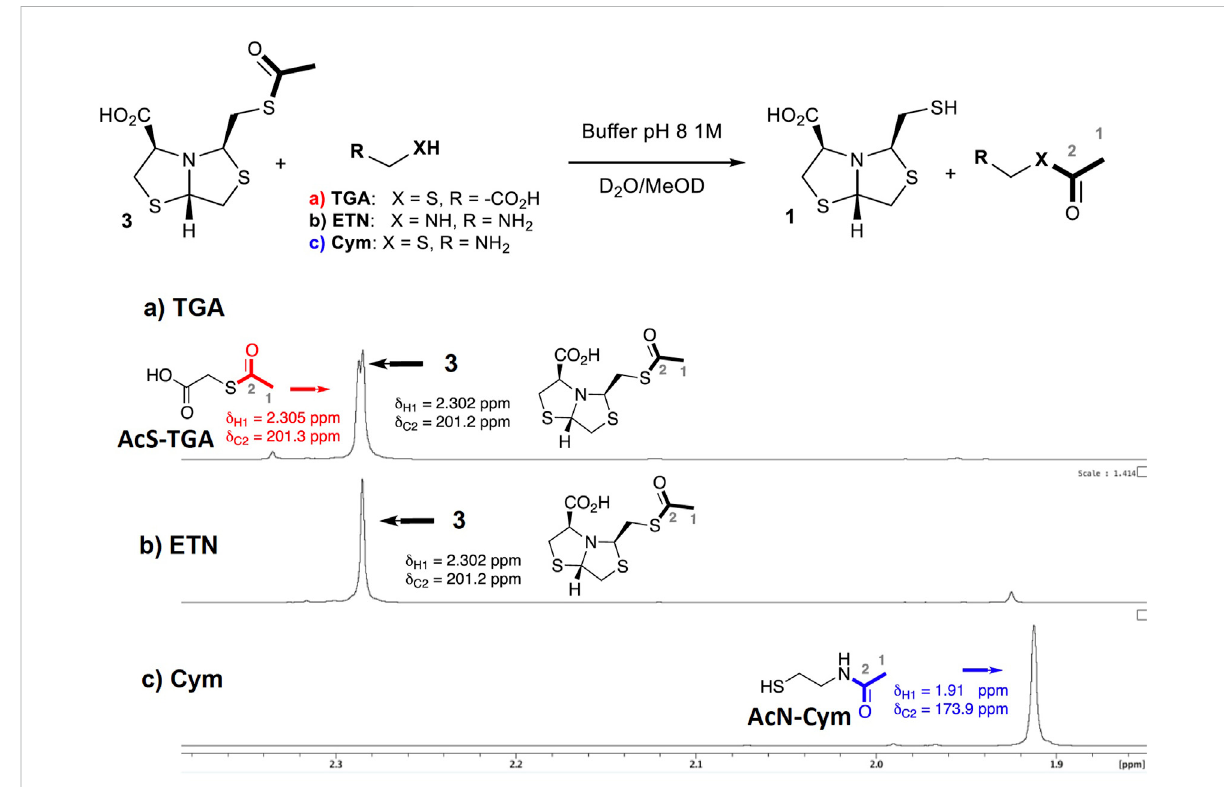
FIGURE 4 Comparison of 1 H-NMR spectra for the deprotectionreaction of 3 using different additives. Reaction of 3 (0.04 mmol) in D 2 O, PB [1 M] atpH 8, andMeOD-d4(10%)at27 ° Cafter 40 min: (A) TGA(0.08 mmol); (B) ethylenediamine(0.08 mmol); (C) Cym 5c (0.08 mmol).The 13 Cchemicalshiftof C2 atoms was obtained from 1 H, 13 C-HMBC correlations to the respective acetyl